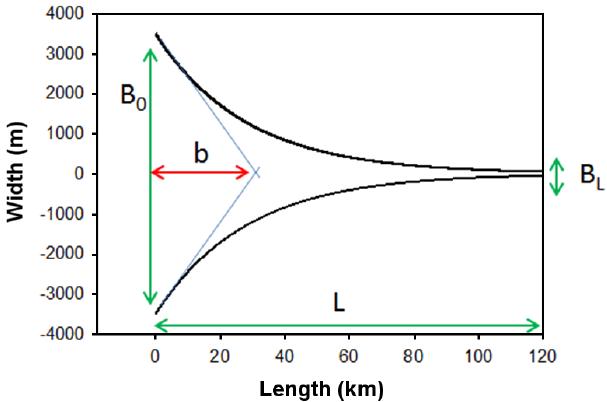
Figure 2. Idealized estuarine geometry and main parameters. Pa- rameters indicated by green arrows are measured; b is calculated. See Sect. 2.3.1 for further